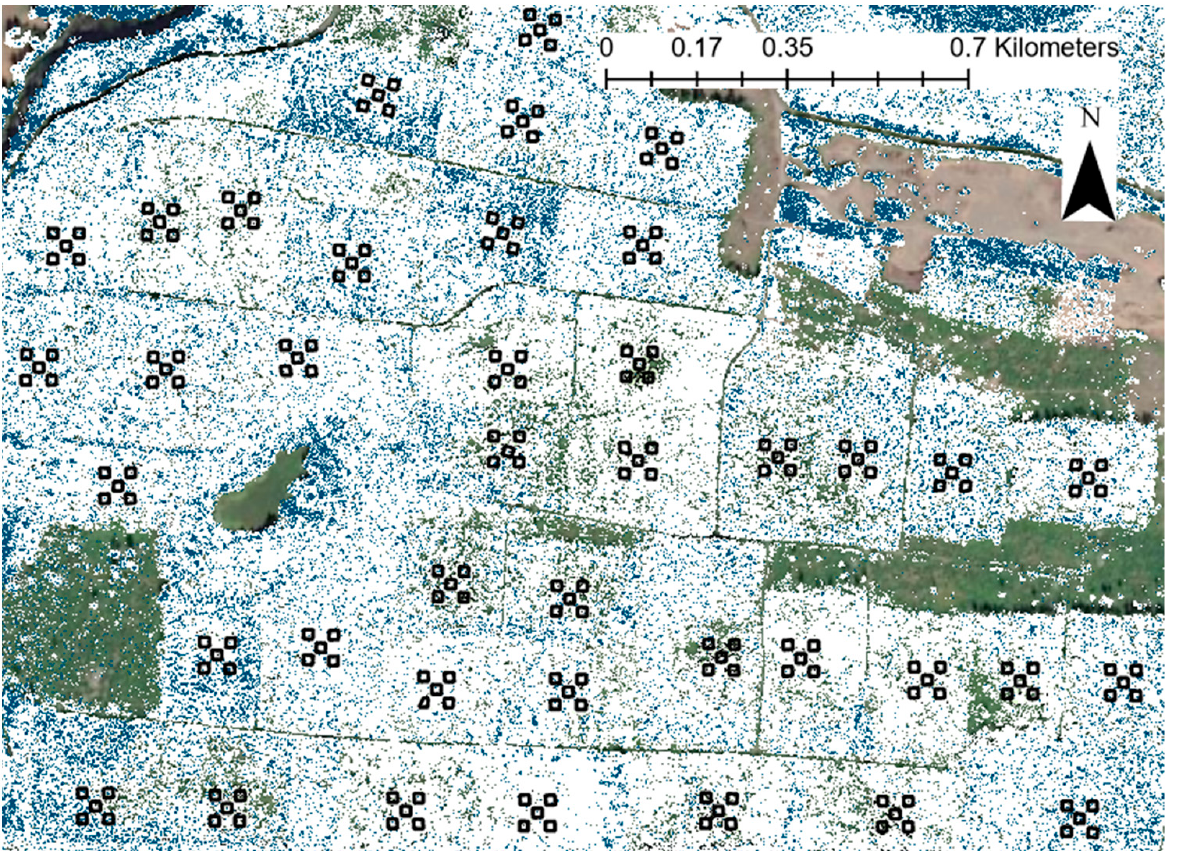
Figure 8. Red alder classification raster overlaid on the entire Sappho LTEP study. Blue pixels represent red alder, white pixels represent not red alder, and all other pixels were identified as non-forest. The black boxes depict the approximate locations of tree plots based on the framework survey data.